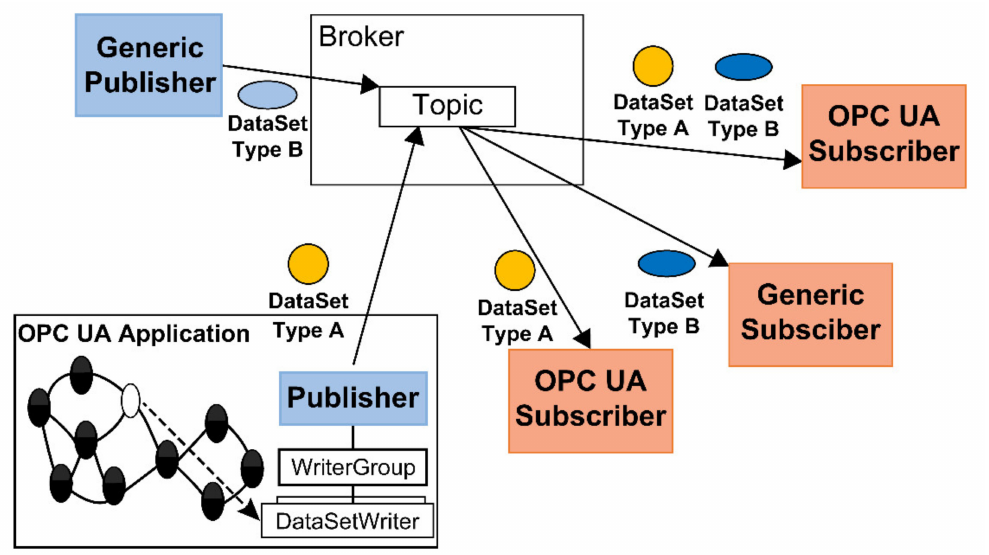
Figure 3. OPC UA PubSub broker communication